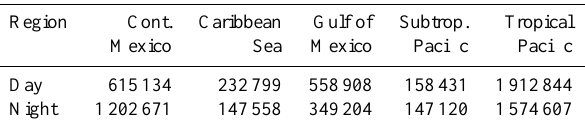
Table 1. Number of hydrometeor profiles registered during day (06:00a.m.–06:00p.m.) and night (06:00p.m.–06:00a.m.) that were averaged over five study regions. Only the pixels with non- zero surface precipitation were taken into